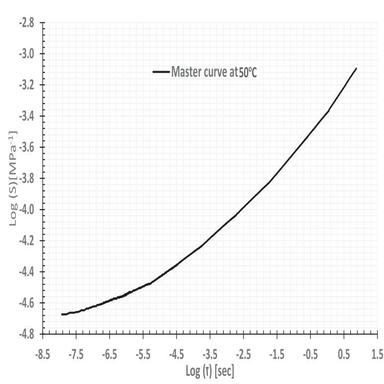
Creep compliance master curve at 50 °C obtained by shifting the master curve at 40 °C using shift factor from WLF model.